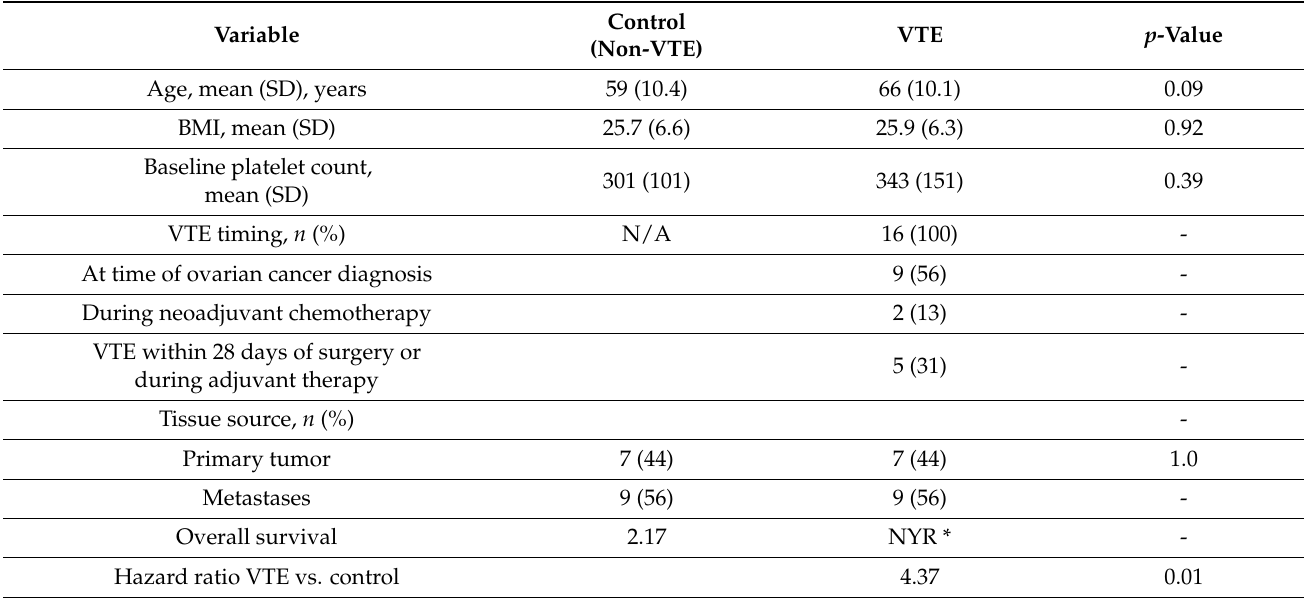
Table 1. Patient